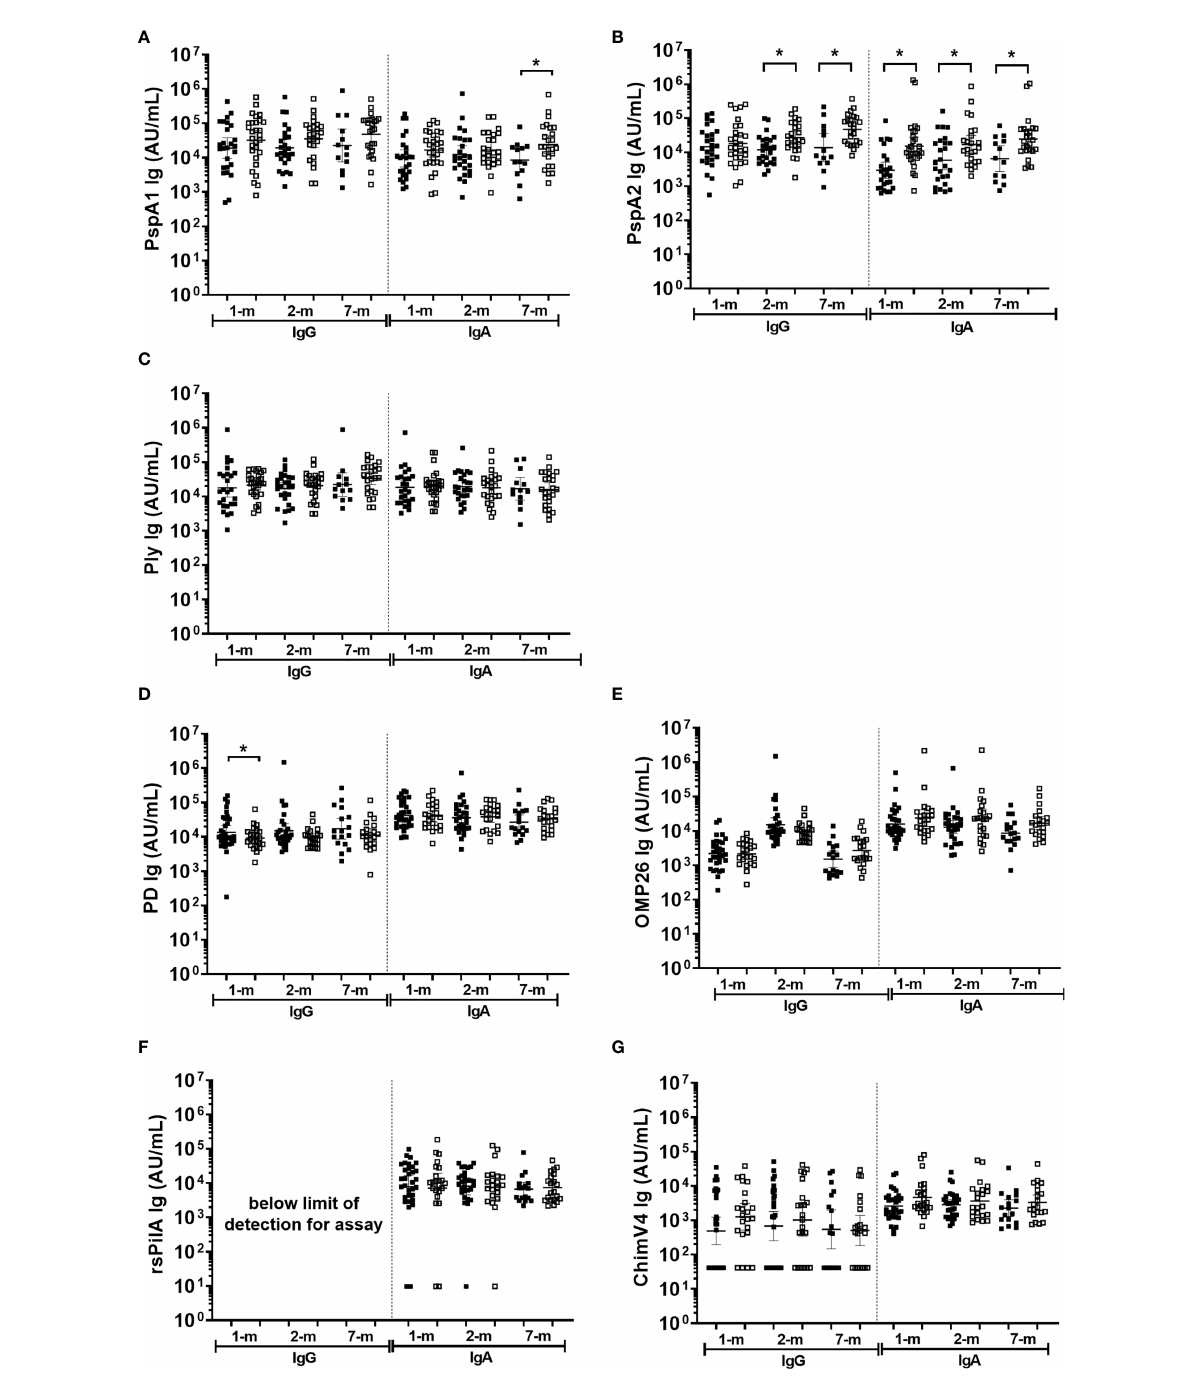
FIGURE 6 Breast milk IgG and IgA titres against Streptococcus pneumoniae and Haemophilus in fl uenzae separated based on any NPS positive to S. pneumoniae or NTHi in the fi rst 7-months of life. Each point represents the breast milk IgG or IgA titres against S. pneumoniae antigens (A) PspA1, (B) PspA2, (C) Ply and H. in fl uenzae antigens (D) PD, (E) OMP26, (F) rsPilA, (G) ChimV4. PspA1, pneumococcal surface protein A family 1; PspA2, pneumococcal surface protein A family 2; Ply, pneumolysin. PD, Protein D; OMP26, outer membrane protein 26; rsPilA, recombinant soluble pilus A protein; ChimV4, chimeric vaccine antigen 4 (rsPilA and P5). Unpaired t-tests were conducted on logarithmically transformed data with * p<0.05. For the 1-month visit n=55, 2-months visit n=51, 7-months visit n=38. Positive NPS = open